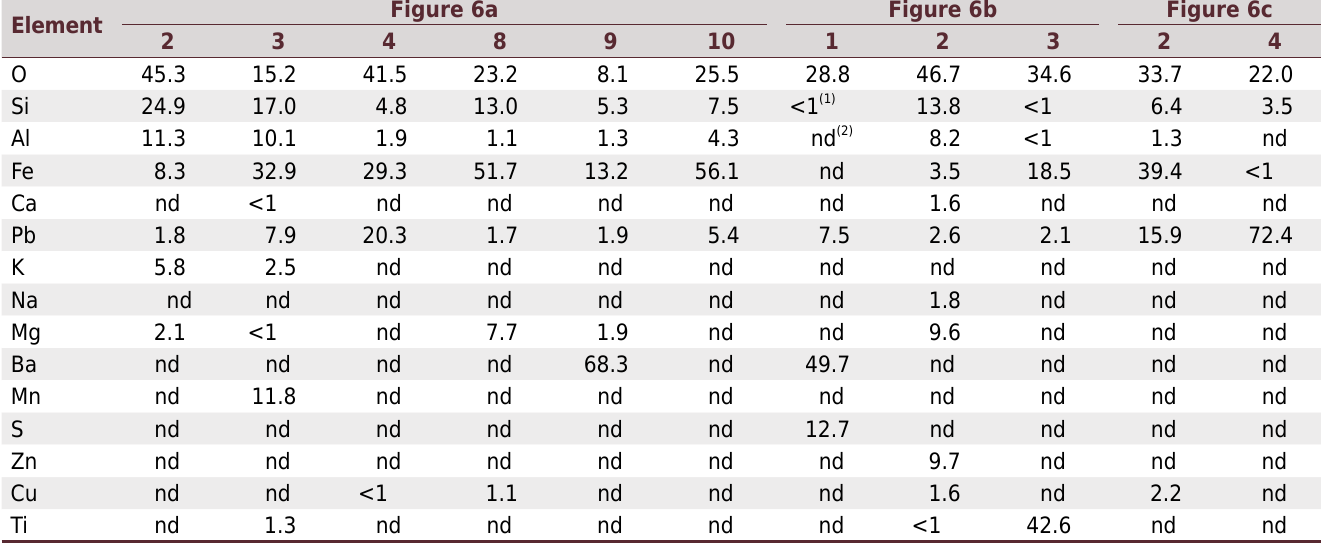
Table 4. Chemical analysis (% - m/m) of sample 15 for selected sand particles identified in figure 6